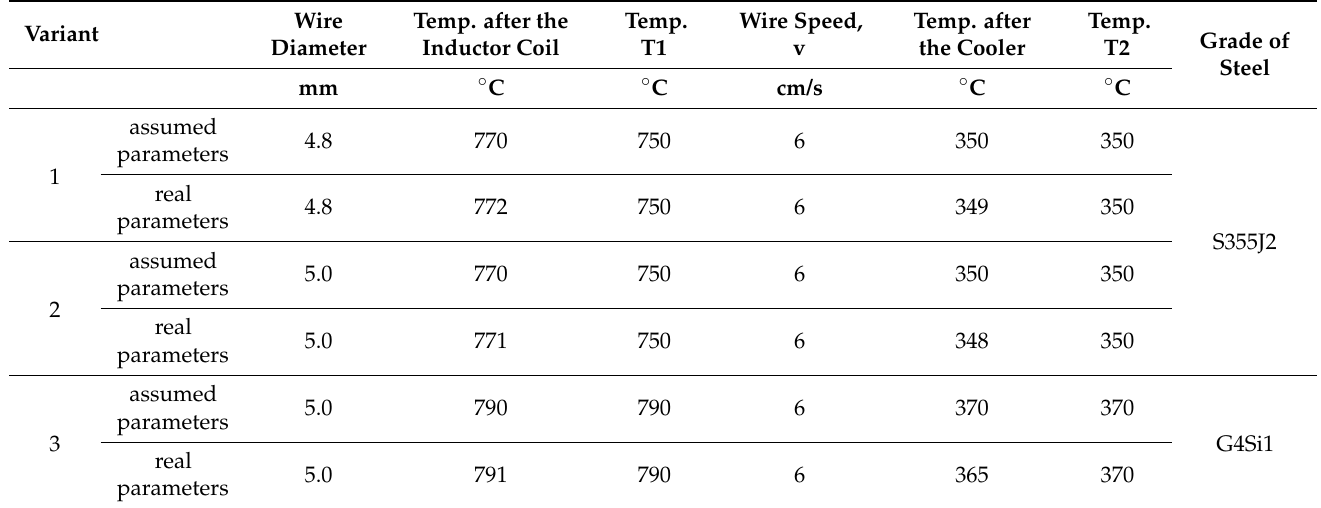
Table 4. TRIP-type heat treatment process parameter